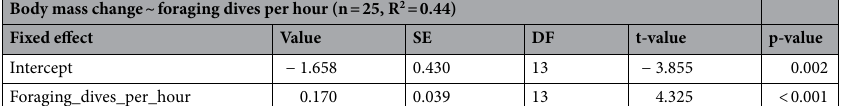
Body mass change ~ foraging dives per hour (n = 25, R 2 = 0.44)